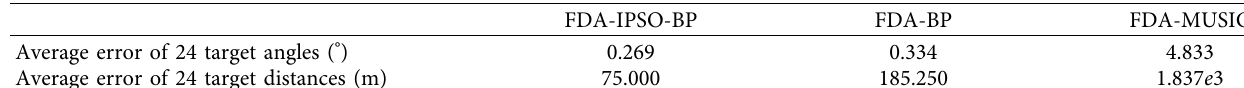
Table 2: The average error of the three algorithms.